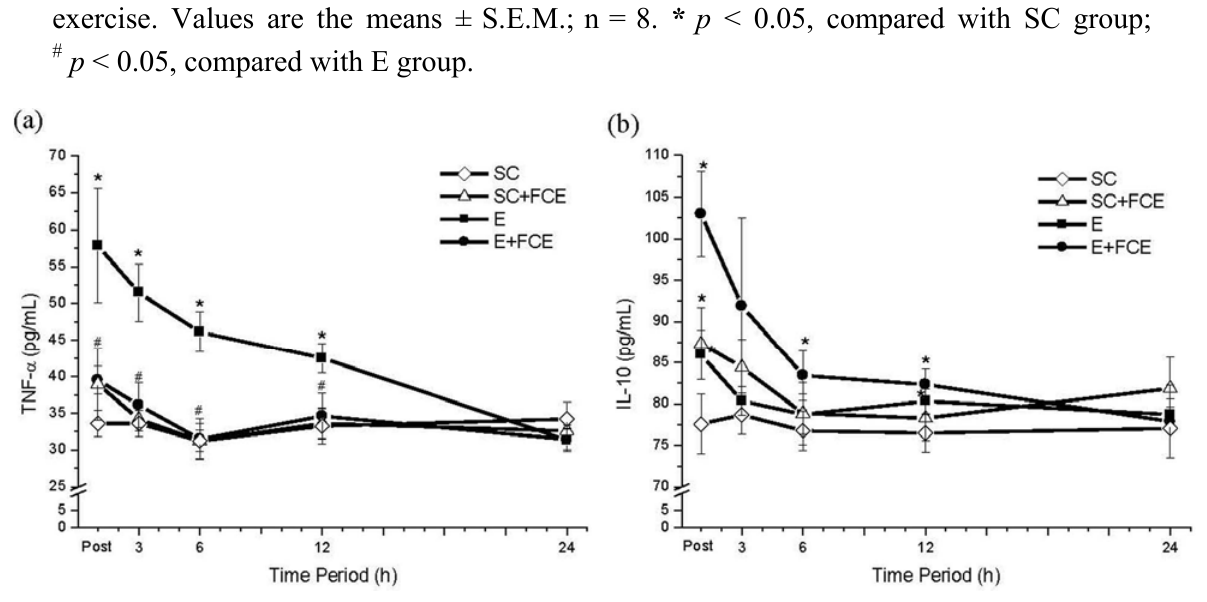
Figure 2. Pro-inflammatory cytokine TNF- α ( a ) and anti-inflammatory cytokine IL-10 ( b ) levels in plasma from groups SC, SC+FCE, E and E+FCE for varying times after exhaustive exercise. Values are the means ± S.E.M.; n = 8. * p < 0.05, compared with SC